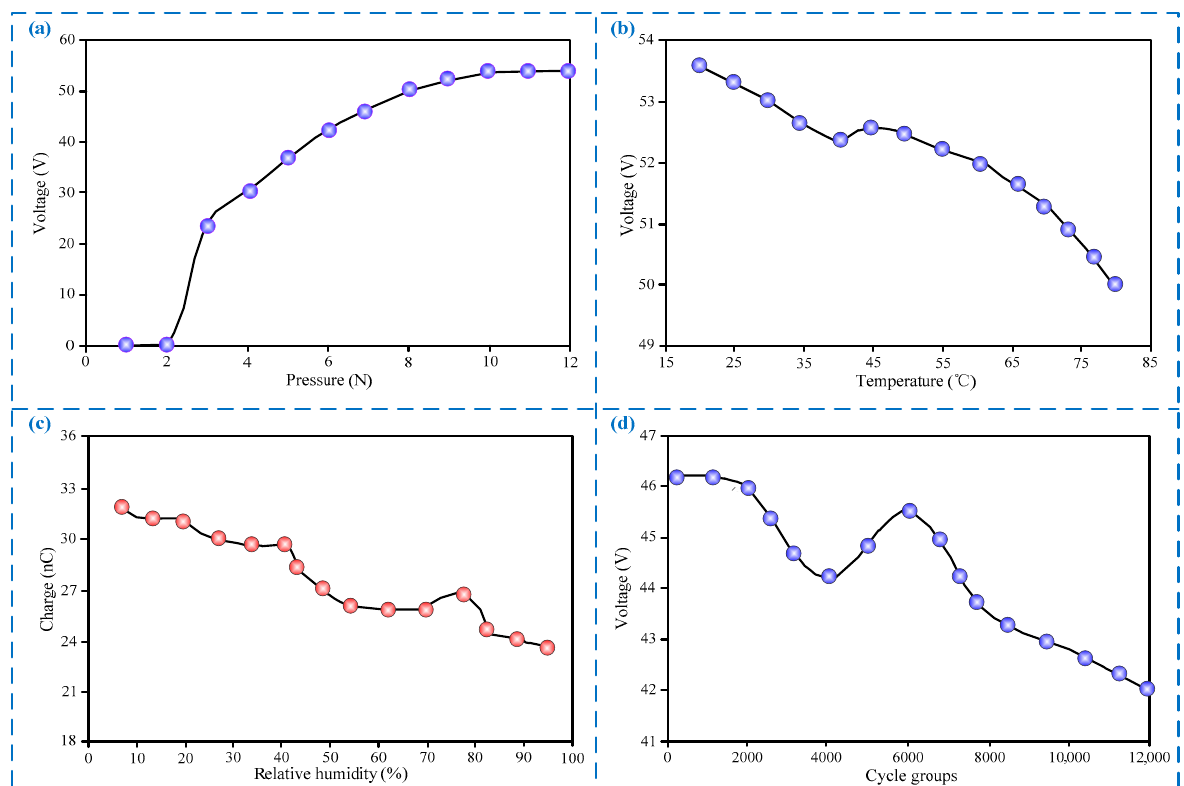
Figure 4. Output signal characteristics of the sensor at different working conditions. ( a ) Output voltage under different pressures; ( b ) output voltage under different temperatures; ( c ) transfer charge under different relative humidity; ( d ) output voltage under different cycles.